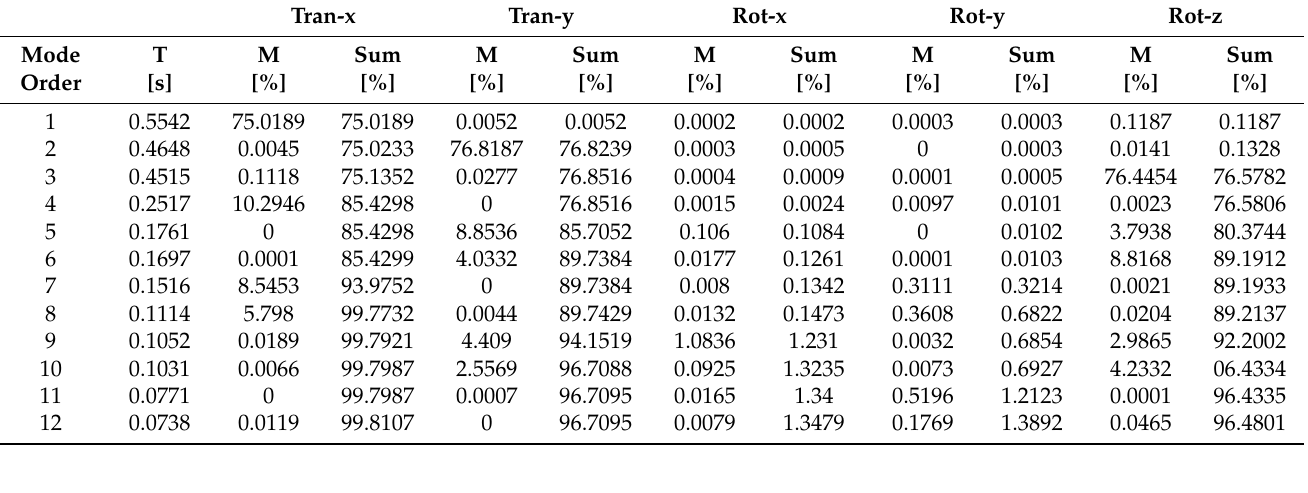
Table 3. Summary of vibration periods and participating mass contributions for the first 12 vibration modes of MU system (LMOD analysis, Midas).